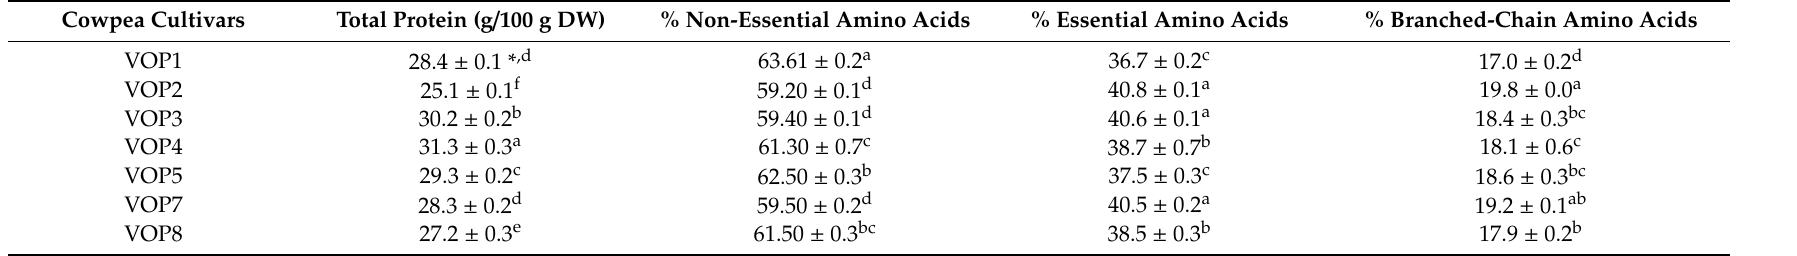
* Data present mean and standard deviation ( n = 3). Di ff erent letters at the same column indicate significant di ff erences at ( p <